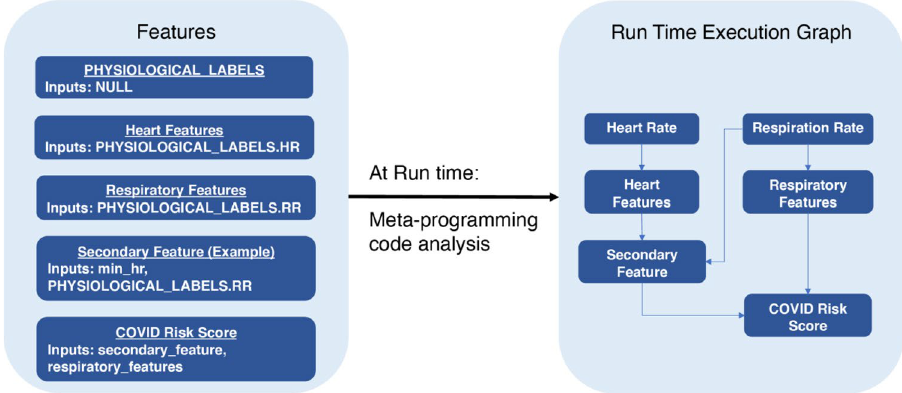
Figure 1. Toy example of an execution graph calculated at runtime. The PHYSIOLOGICAL_LABELS feature represents the standardized wearables data inputs and acts as source nodes in the